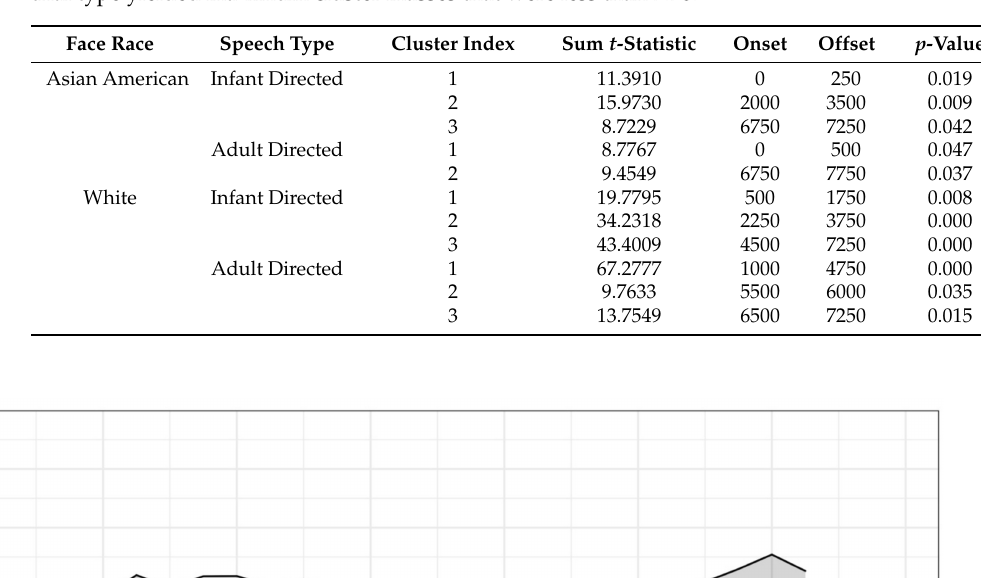
Table 7. Significant clusters for each chance comparison permutation analysis. Our threshold of significance was established by our permutation analyses; at least 95% of the permutations for each trial type yielded maximum cluster masses that were less than 7.76.